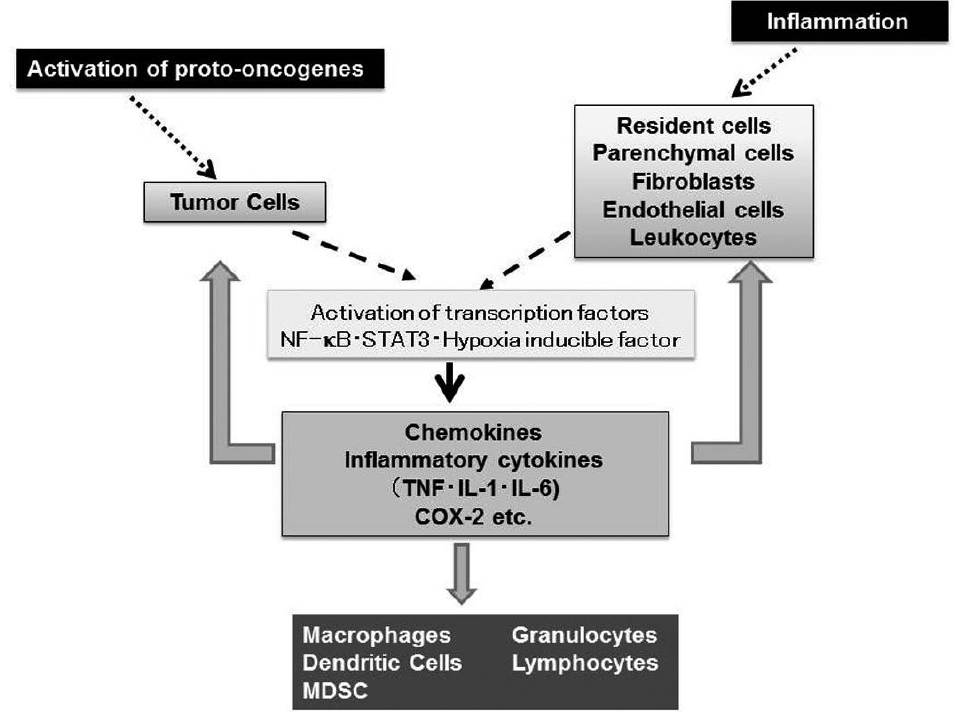
Figure 1. Pathways shared by tumorigenesis and